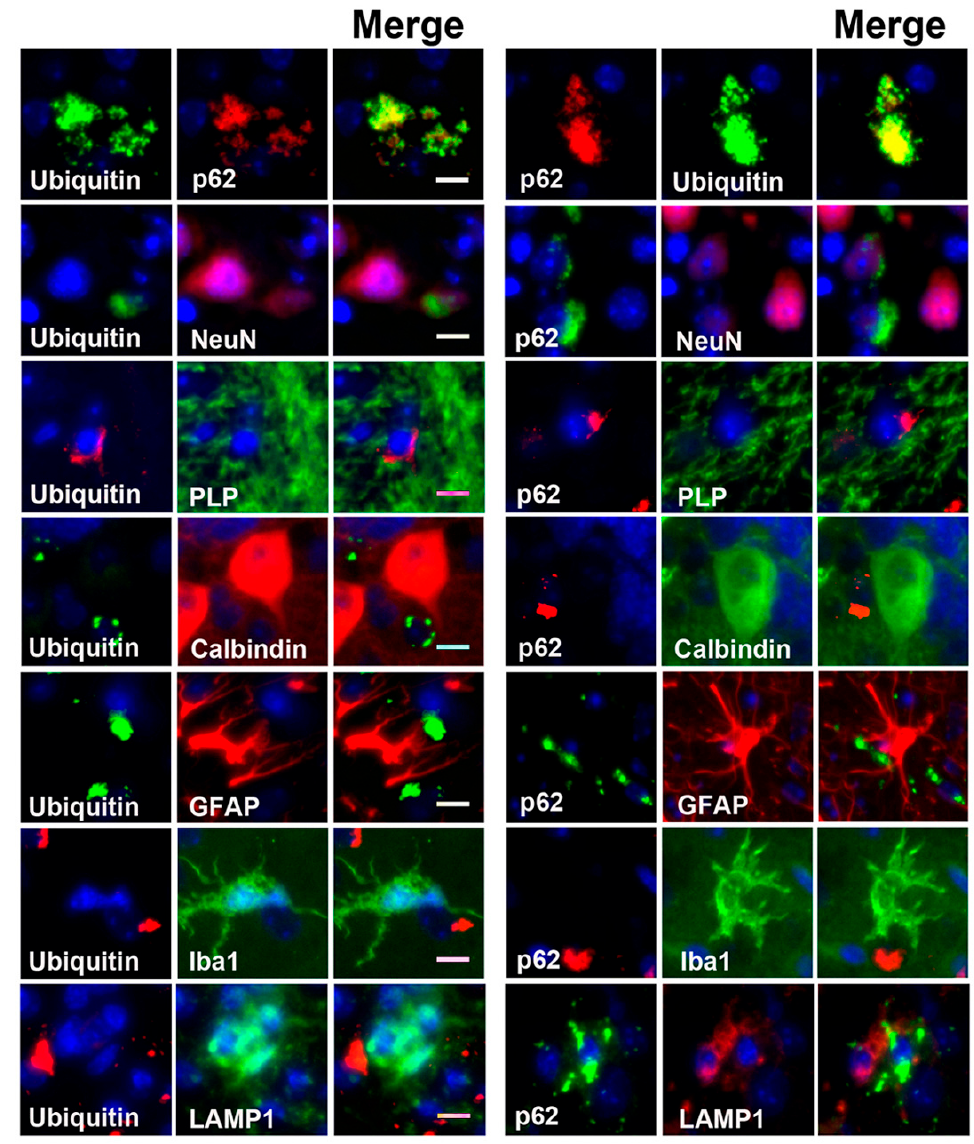
Figure 3. Accumulation of ubiquitin / p62 aggregates in oligodendrocytes and neurons. Sections of twitcher brain were double labeled with anti-ubiquitin / anti-p62 and anti-NeuN (neuron) / anti-PLP (oligodendrocytes) / anti-calbindin (Purkinje cells) / anti-GFAP (astrocyte) / anti-Iba1 (microglia) / anti-LAMP1 (lysosome), respectively, and nuclei were counter-stained with DAPI (blue). Scale bars: 10 µ m.